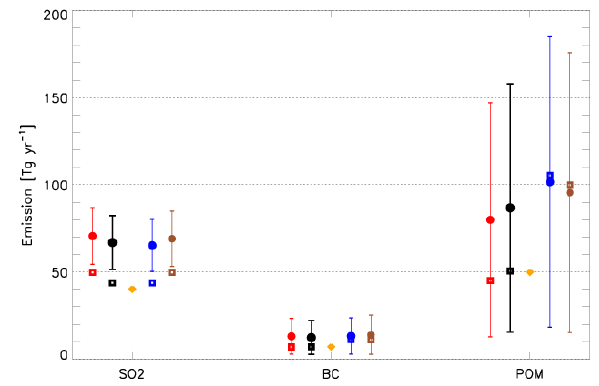
Fig. 10. Global-yearly FG (squares) and AN (circles) emissions of SO 2 (in TgSyr − 1 ), BC and POM (in Tgyr − 1 ) from experiments ACFED (black), ACFAS (blue), AEFED (red) and AEFAS (brown) for the year 2010. Vertical lines correspond to uncertainties of the corresponding fluxes. Projected RCP emissions are also illustrated (diamond gold). Uncertainties correspond to two standard deviations.